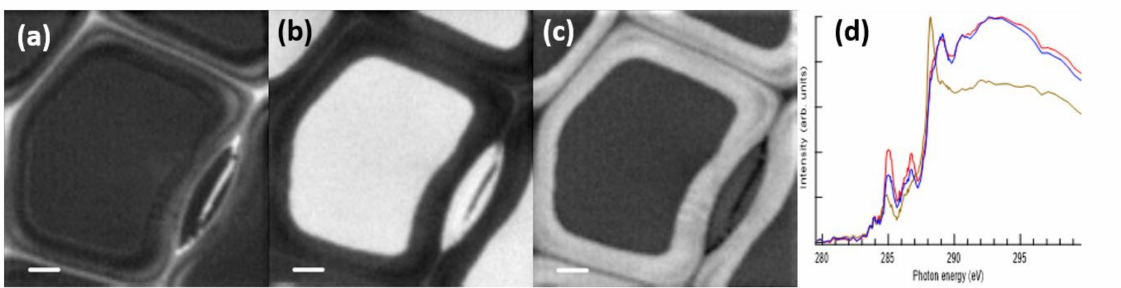
Figure 6. The extracted C 1s XAS and their localisation in a resin-embedded knotwood cell. ( a ) Localisation of the cell corner- and the compound middle lamella-type of spectra. ( b ) Localisation of the epoxy resin spectrum. ( c ) Localisation of the secondary cell wall spectrum. ( d ) Spectra of di ff erent ROIs: cell corner and compound middle lamella (red line), epoxy resin extracted from the middle of the cell lumen (brown line), secondary cell wall (blue spectrum). Scale bar is 2 µ